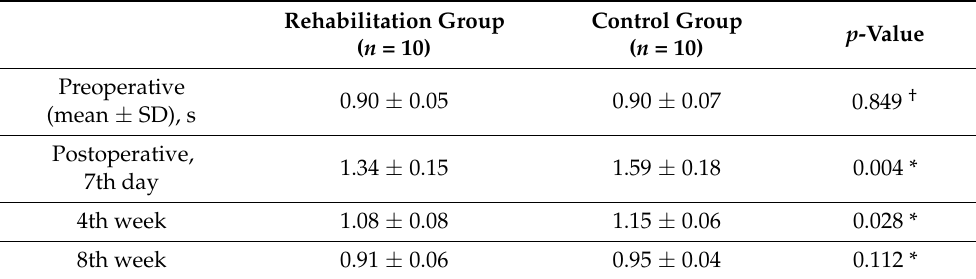
Table 4. Pharyngeal transit time on videofluoroscopic swallowing